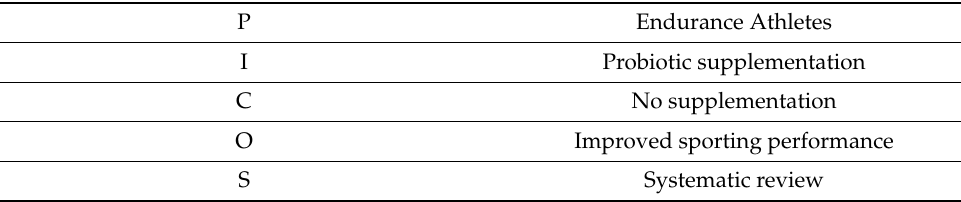
Table 1. PICOS criteria (Population; Intervention; Comparison; Outcome; Study design).